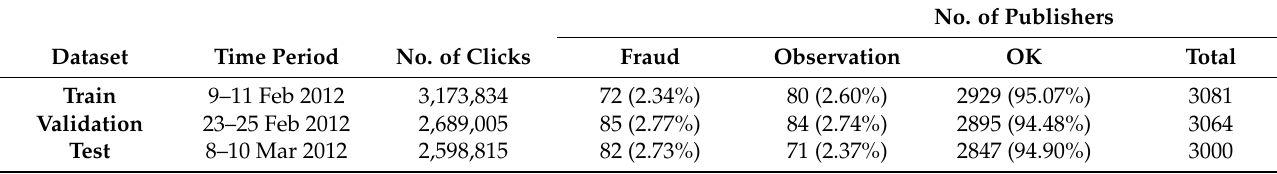
Table 1. Statistics of the FDMA 2012 BuzzCity